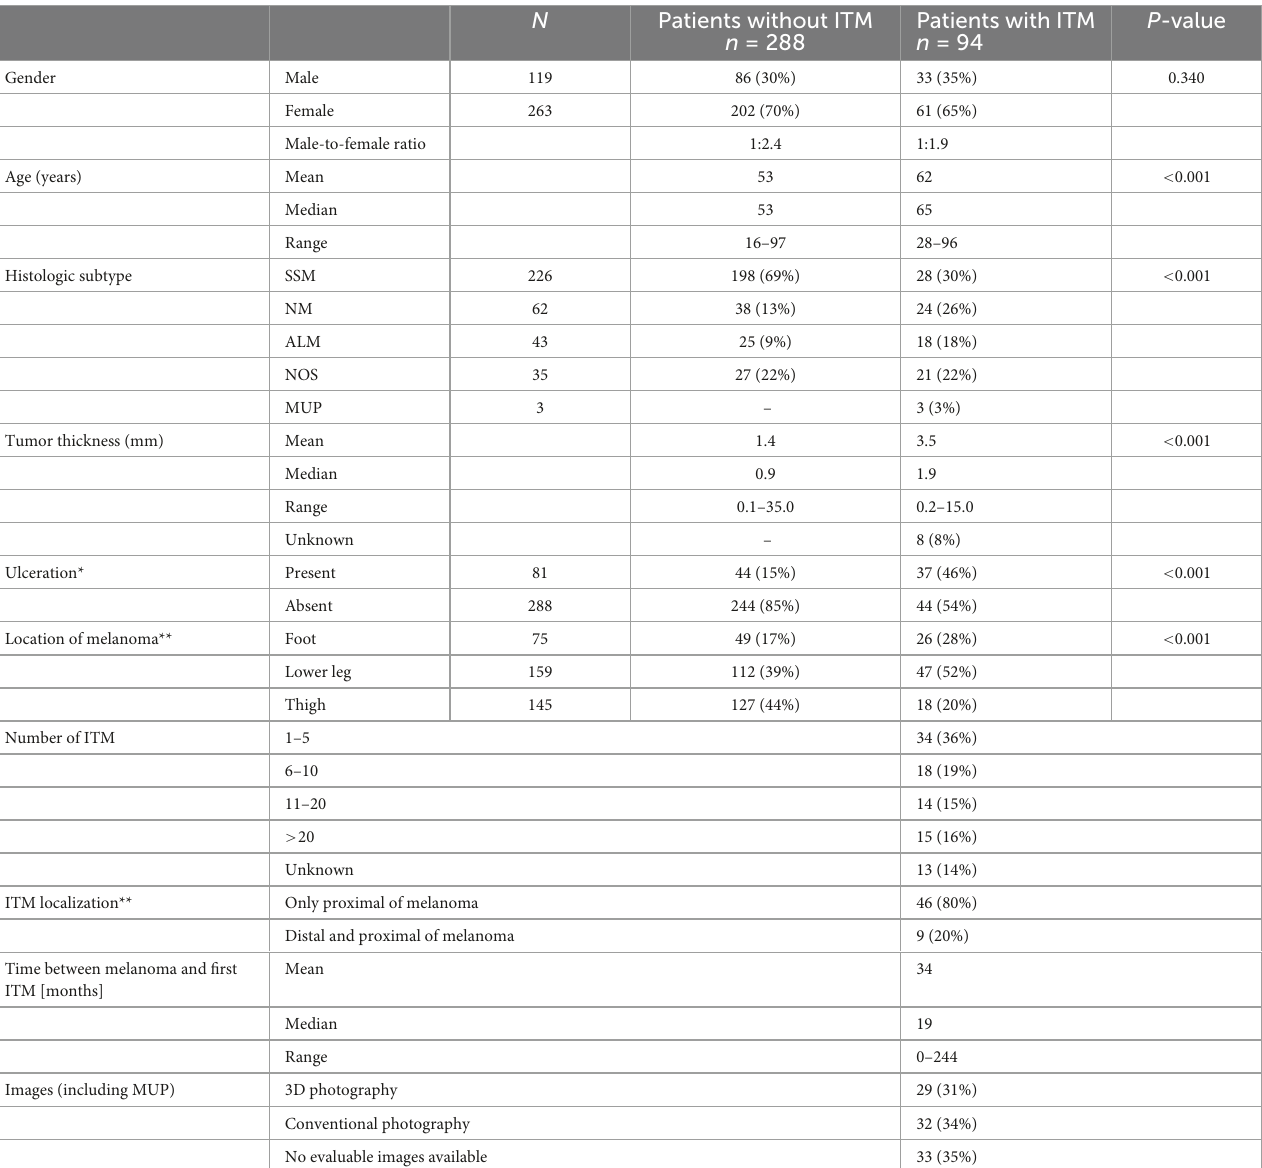
TABLE 1 General patient characteristics.